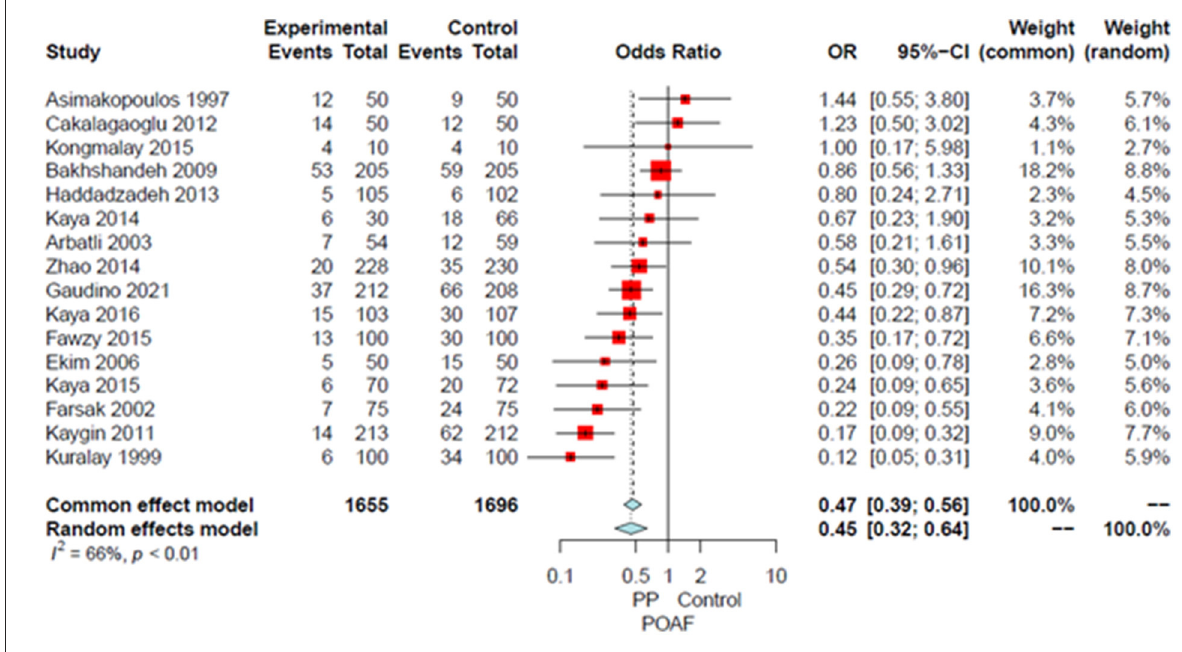
FIGURE1 Forest plot for postoperative atrial fibrillation. CI, confidence interval; OR, odds ratio; POAF, postoperative atrial fibrillation; PP, posterior pericardiotomy.